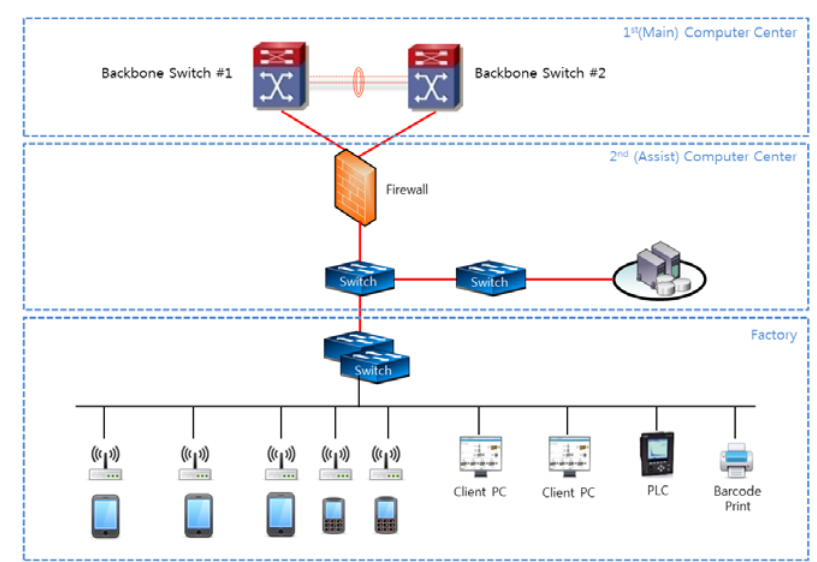
Figure 20. Process of Network Configuration.